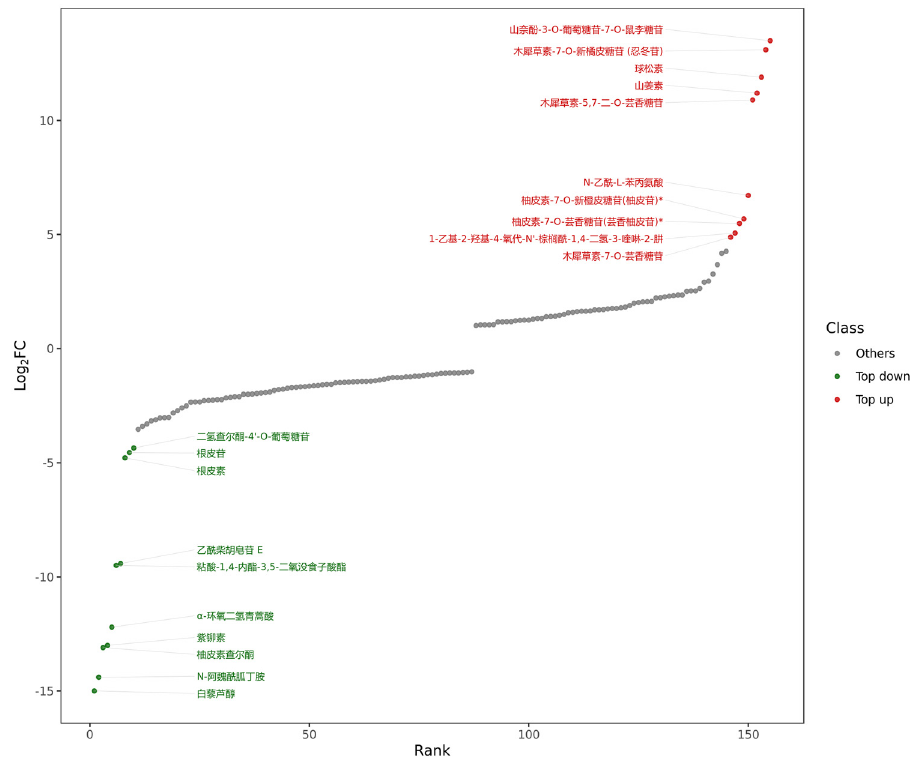
Figure 4: Dynamic distribution diagram of the di ff erences in the metabolite